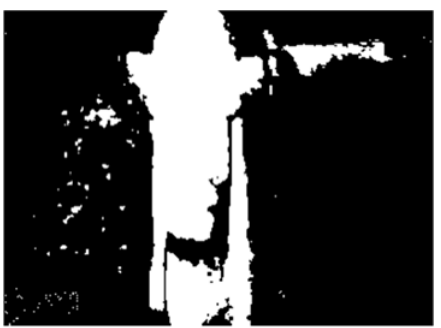
Figure 12. Binary image (0.1<| hag ‐ ag2b| <1) of difference: | hag ‐ ag2b| .